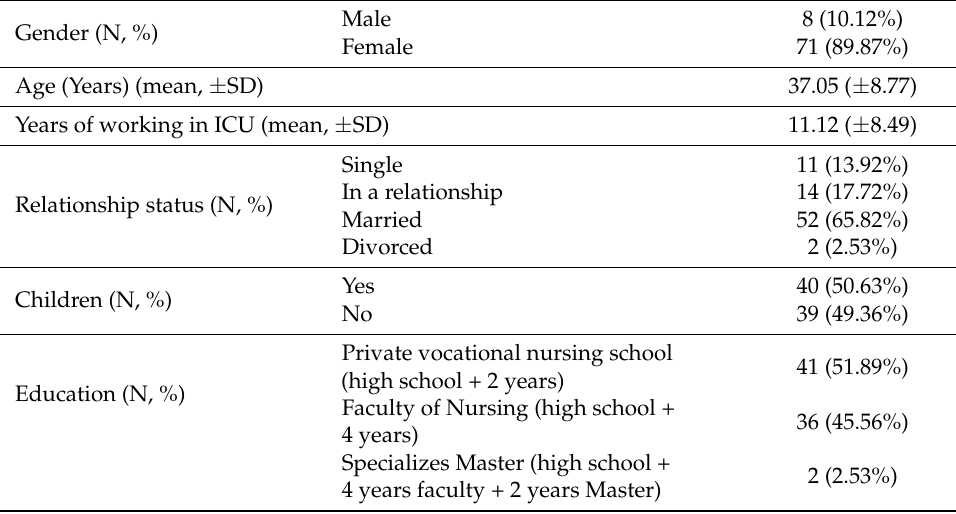
Table 2. Characteristics of the